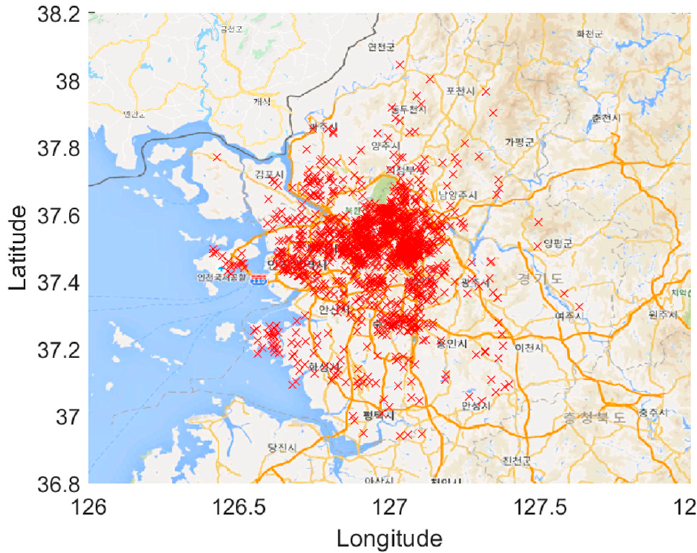
Figure 1. Commuter data expressed in MATLAB for each district.